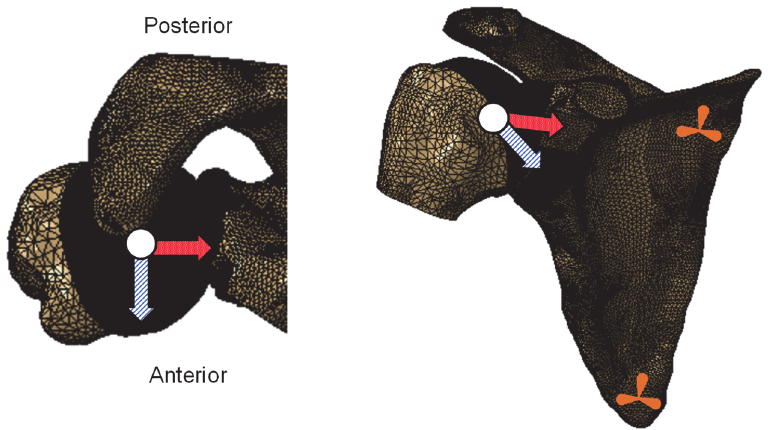
Figure 3. Illustration of the finite element meshes and loading and boundary conditions considered. Orange symbols on the scapula represent fully constrained displacement conditions. The red dotted arrows represent the direction of compression, while the arrows with diagonal stripes represent the anterior